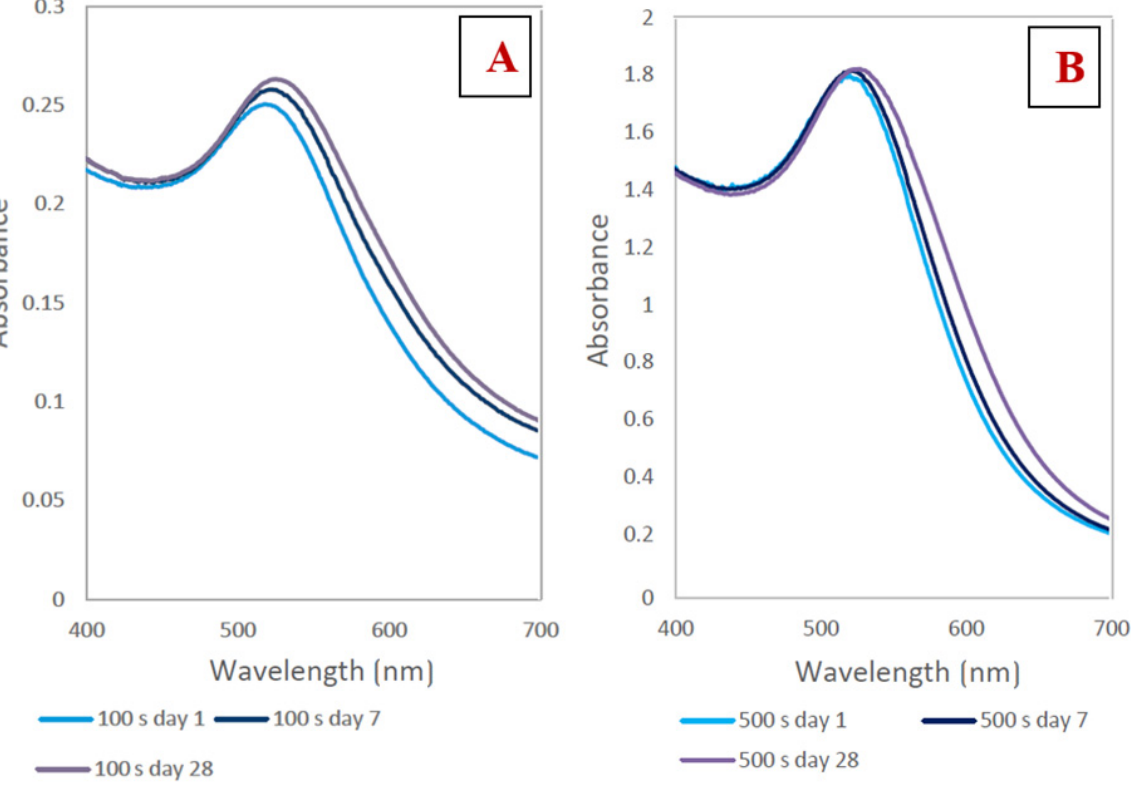
Figure 4. ( A ) Absorbance of AuNPs in PEG/TCD/H 2 O with a TCD/H 2 O ratio of 0.5 g/100 mL prepared with a deposition time of 100 s during the aging process; ( B ) absorbance of AuNPs in PEG/TCD/H 2 O with a TCD/H 2 O ratio of 2 g/100